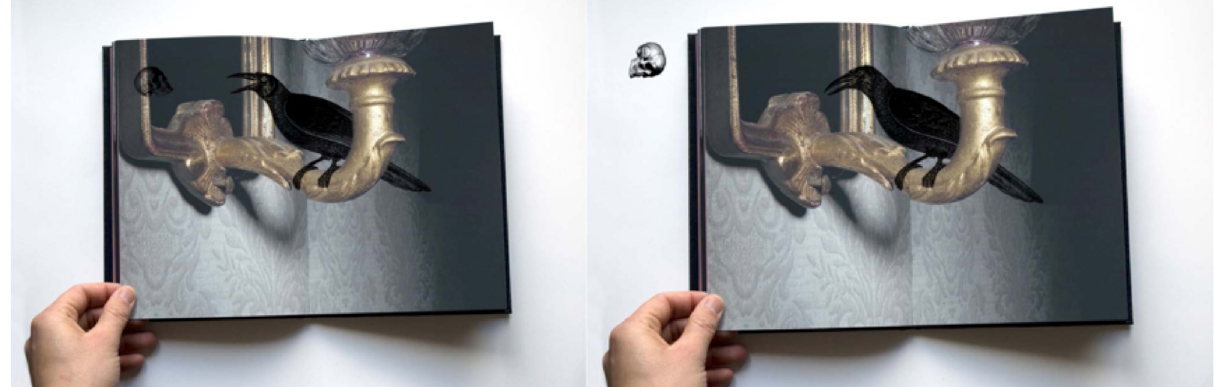
Figure 4 | The virtual bird appears to be part of the space depicted in the image. A scull flies out of the page and enters the space surrounding the book. Images: Scherrer et al.